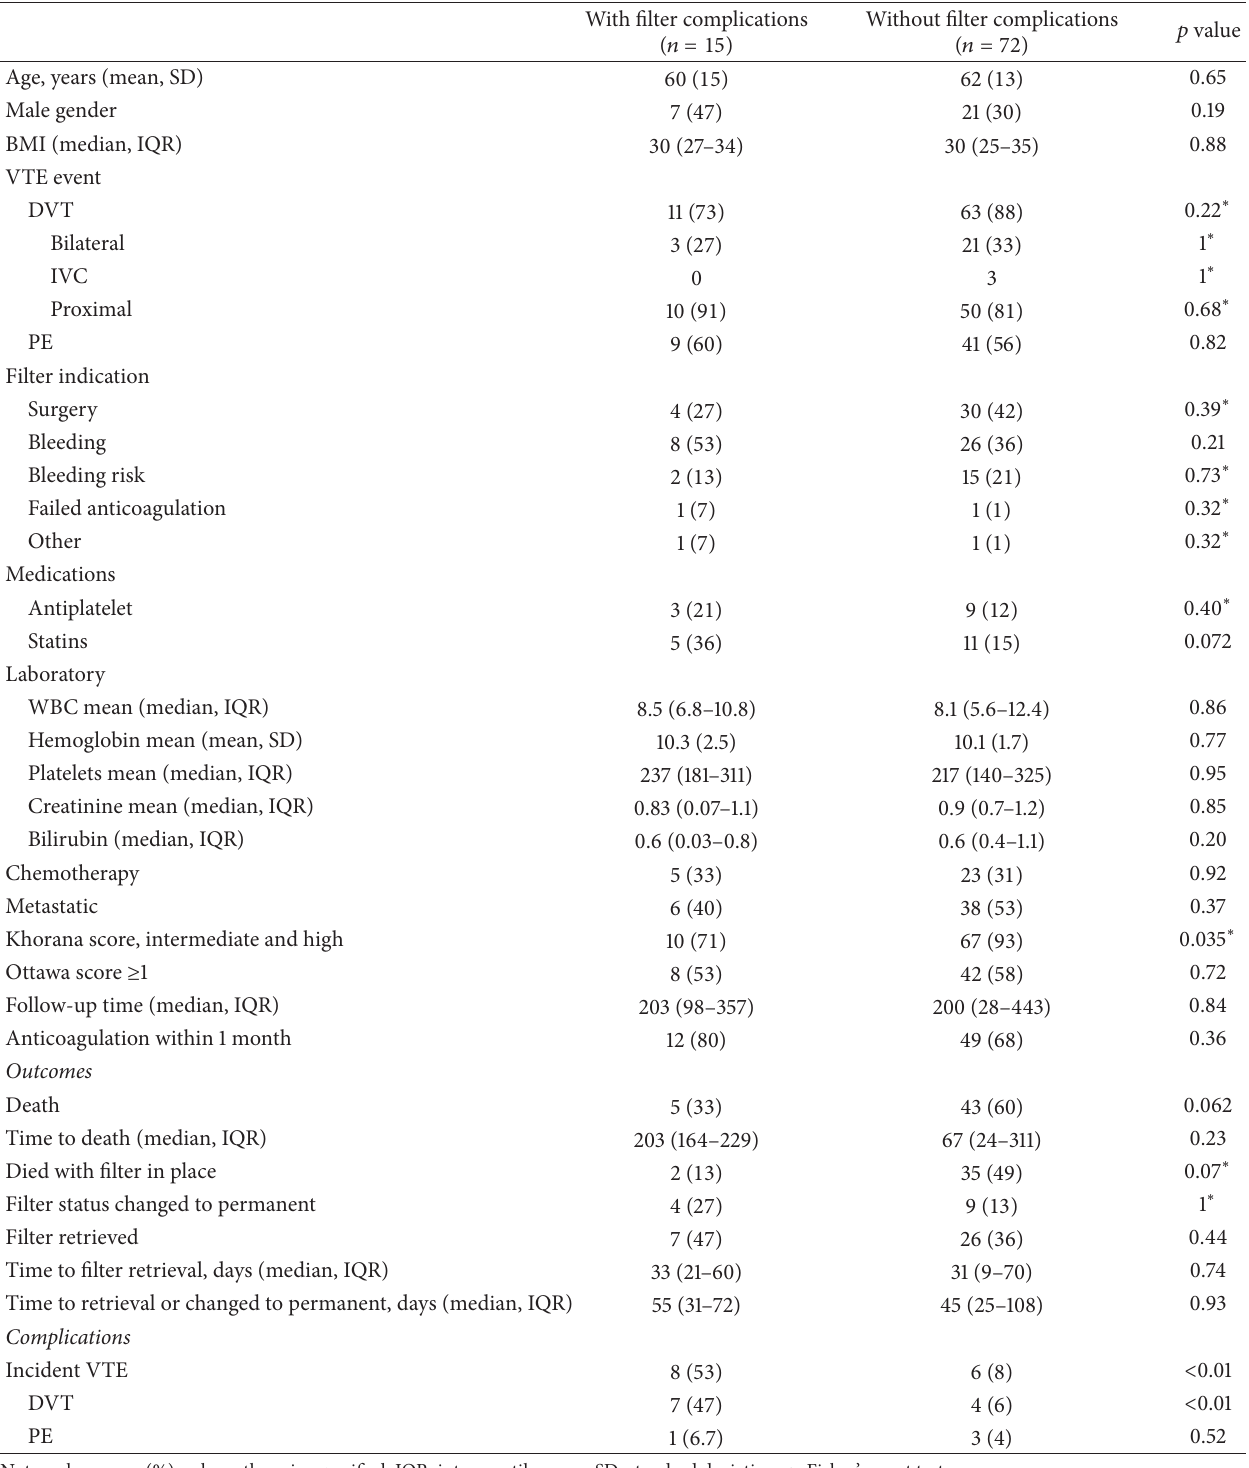
Table 3: Clinical characteristics in patients with active cancer ( 𝑛 = 87 ) with and without filter